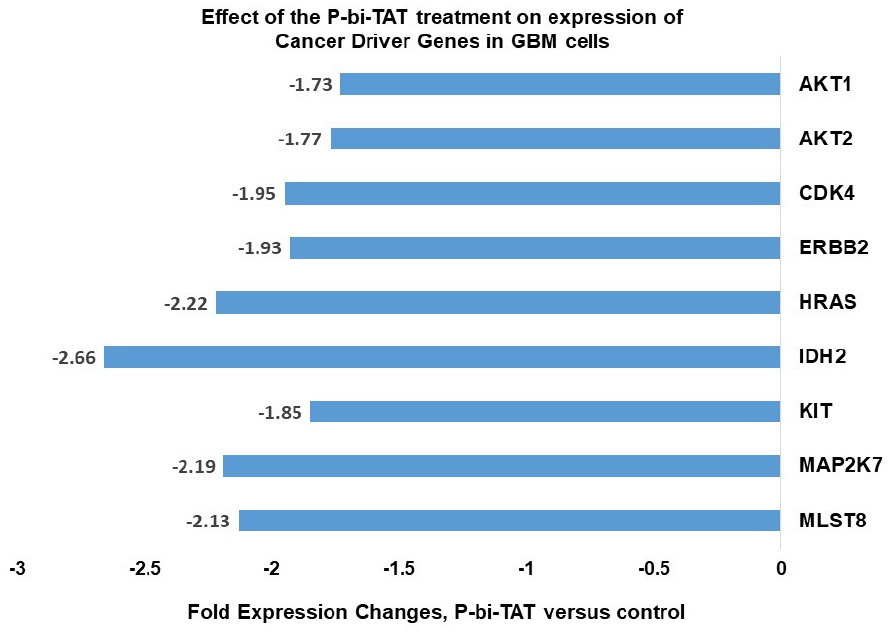
Figure 1. Effects of P-bi-TAT treatment on expression of selected cancer driver genes in primary GBM cells. Cancer driver genes manifesting most significant downregulation of expression in response to P-bi-TAT treatment are shown. Listed values report fold expression changes (log scale) for corresponding genes ( p < 0.05).